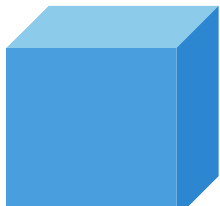
Figure 2: Three-dimensional matrix diagram.